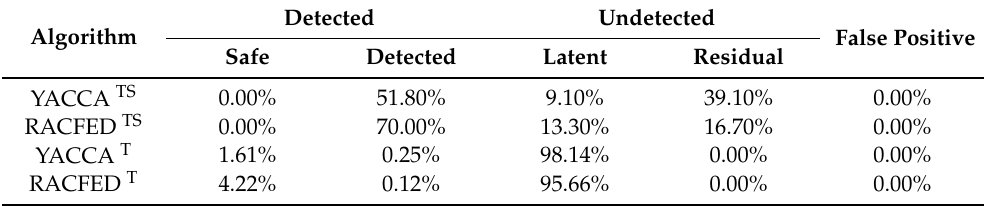
False PositiveAlgorithm